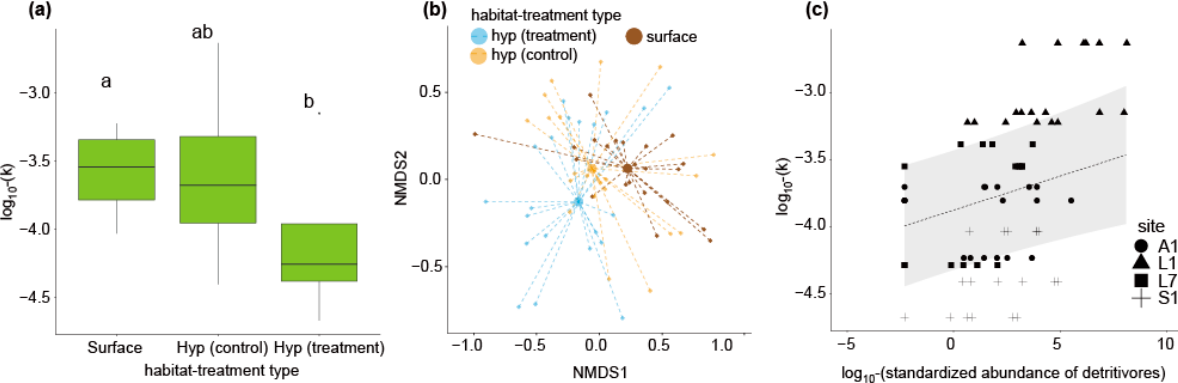
Figure 3. Comparisons of log 10 -transformed leaf litter decomposition rate ( k ) in relation to the habitat-treatment types ( a ), biplots as a result of NMDS ( b ), and a relationship between the log 10 -transformed abundance of detritivores and k ( c ). In ( a ), alphabetical letters denote results of multiple comparisons based on GLMM; those with the same letters were statistically undistinguishable. Multiple comparisons were performed among sites. In ( b ), large circles represent centroids of data points for each habitat-treatment group. In ( c ), a regression line based on a GLMM and 95% confidence intervals are shown.